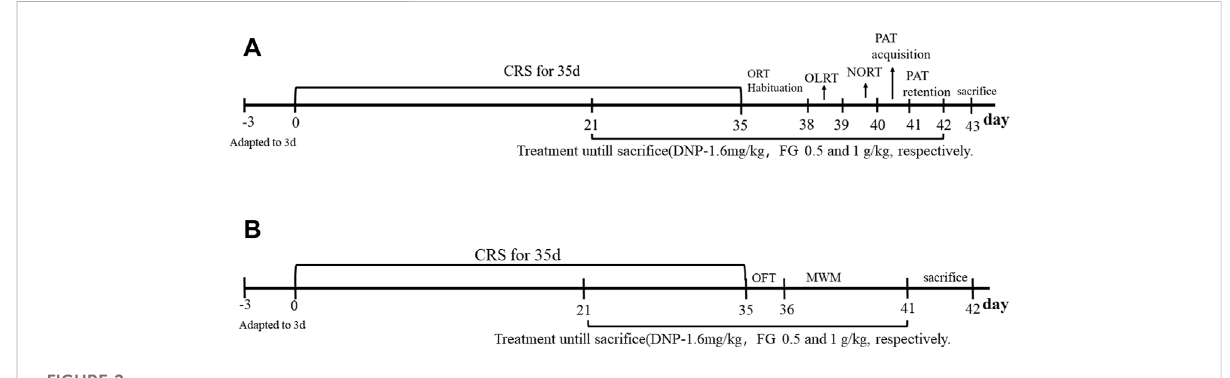
FIGURE 2 Experimental timeline of the study. (A) , (B) Two